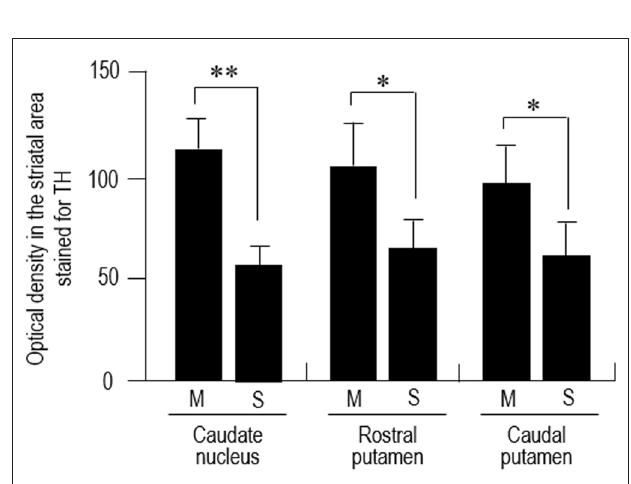
FIGURE 5 | Densitometric analysis of the human striatum stained for TH. Measurements of the optical density of TH-immunoreactive DAB products were performed in the striosome (S) and matrix (M) compartments of the CN, rostral putamen and caudal putamen. Data represent means ± SEM (bars), n = 25. ∗∗ indicates P = 0.01, M vs. S; ∗ indicates P = 0.05, M vs. S.